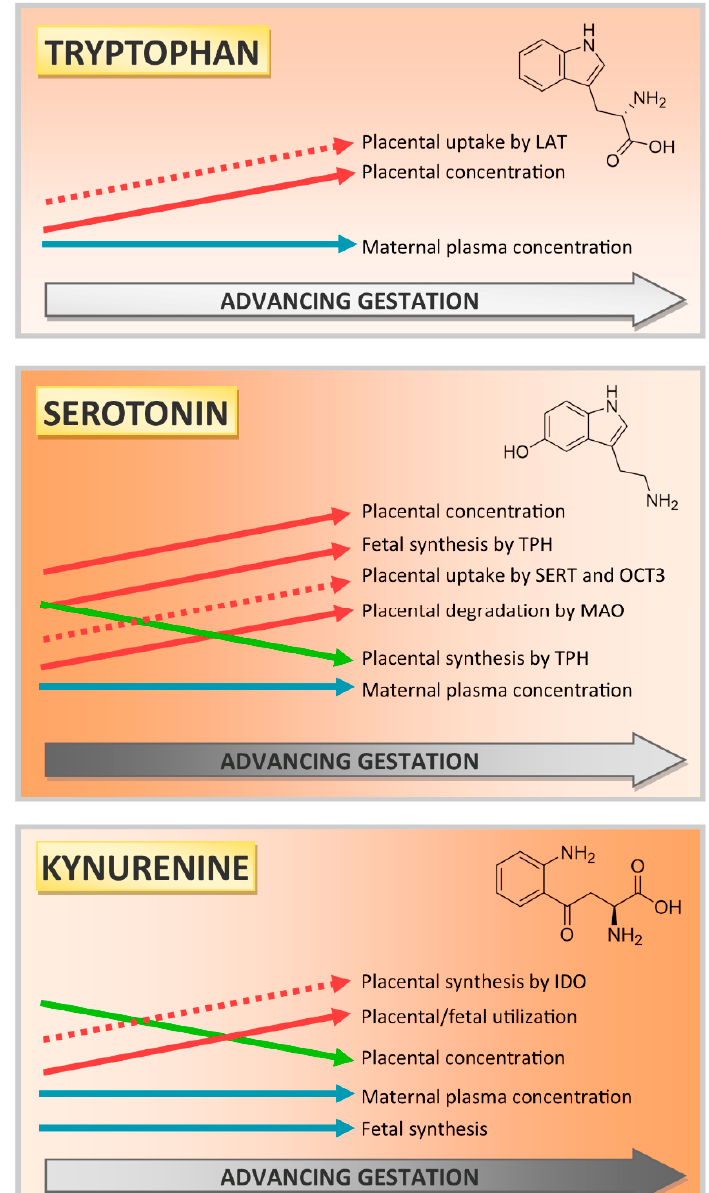
Figure 7. Schematic depiction of the TRP metabolic pathways in the rat fetoplacental unit during gestation. Although basal levels of TRP, 5-HT, and KYN in maternal plasma remain stable during gestation, their concentrations change significantly in the placenta and fetal organs. Based on our results and literature research [19,32–37] we show that the placental metabolism of TRP to 5-HT is important up to mid-gestation, with a subsequent decline (as the fetus becomes independent of placental sources of 5-HT). On the other hand, the placental production and utilization of KYN increase during pregnancy. Full arrows show metabolic activity or concentration levels, and dotted arrows show the gene or protein